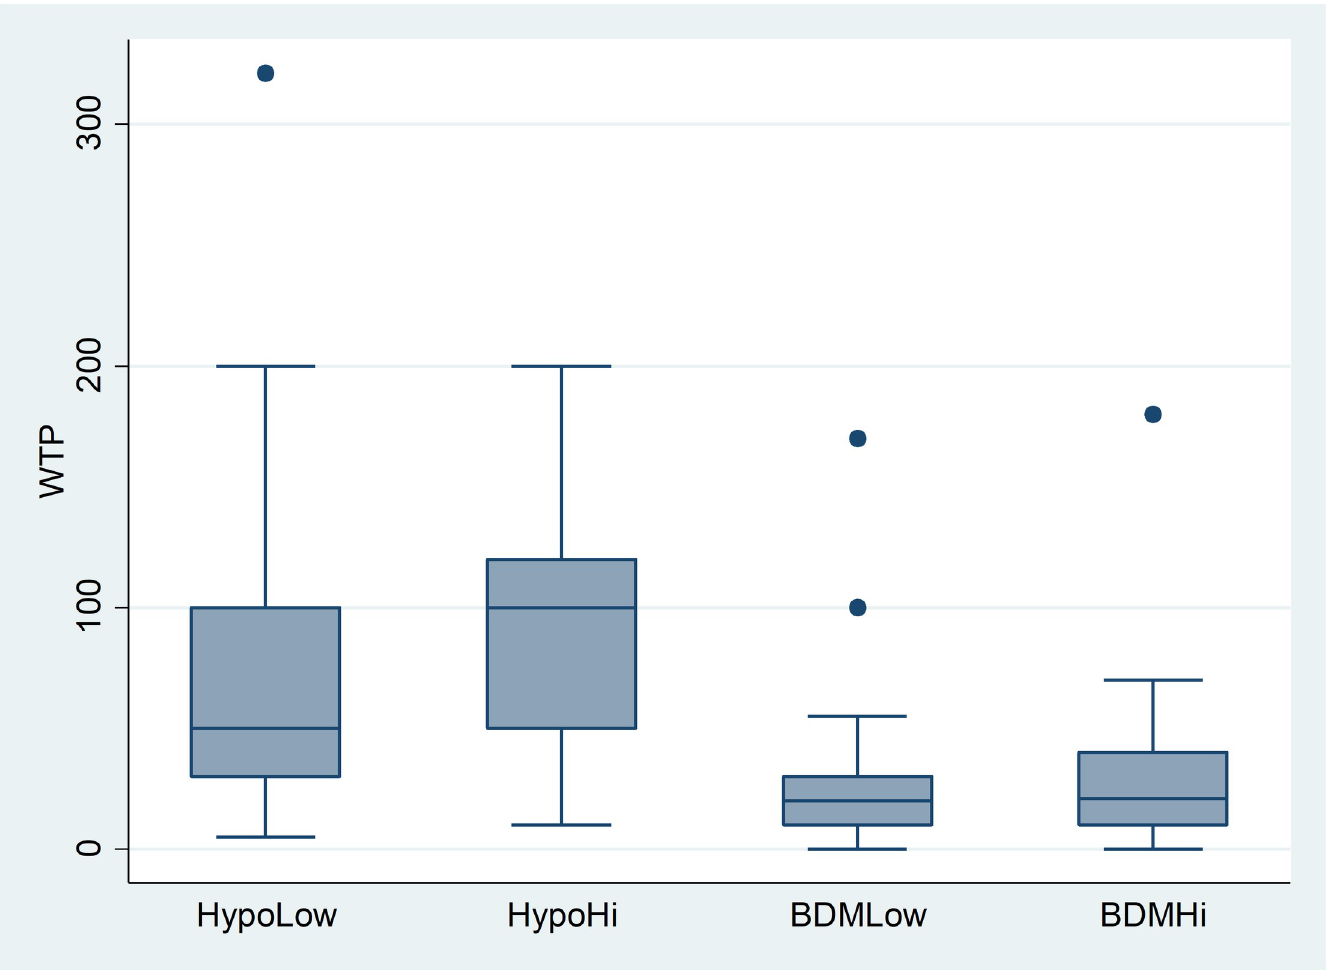
Fig 1. Experiment 1: WTPs by treatment (in PLN). The blue rectangle represents the middle 50% of the data (from the first quartile to the third), the line inside the box shows the median (the second quartile). The whiskers represent the top and bottom 25% values, excluding outliers, which are represented by dots.